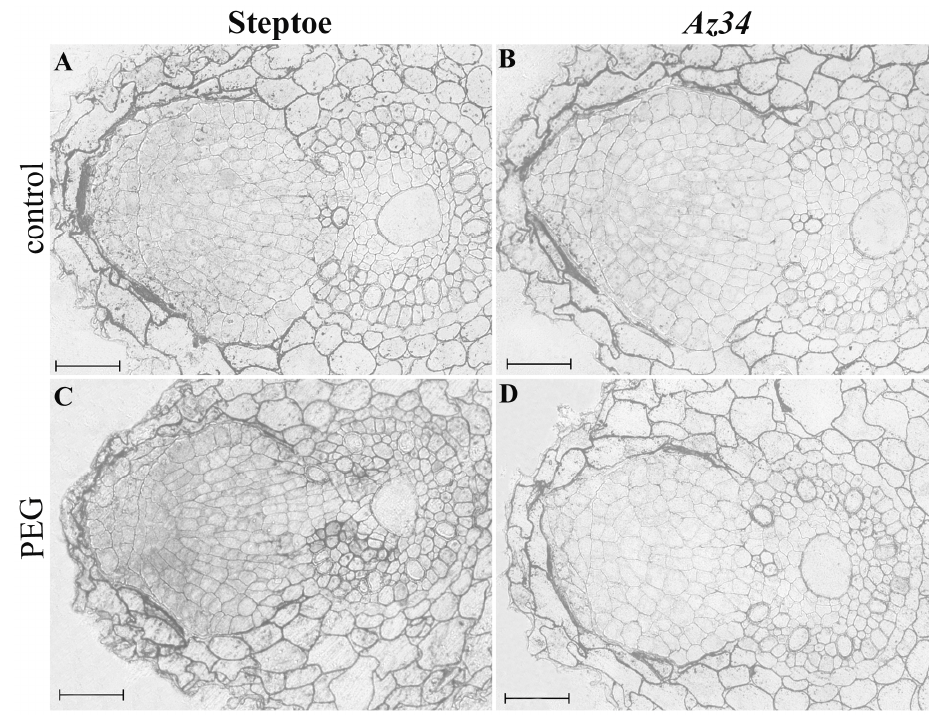
Figure 4. Effect of 6% polyethylene glycol (PEG) treatment on immunolocalization of ABA in the cells of root primordia of Steptoe ( A , C ) and Az34 ( B , D ) plants; A , B —plants grown under normal conditions; C , D —stressed plants. Scale bar is 50 µm.